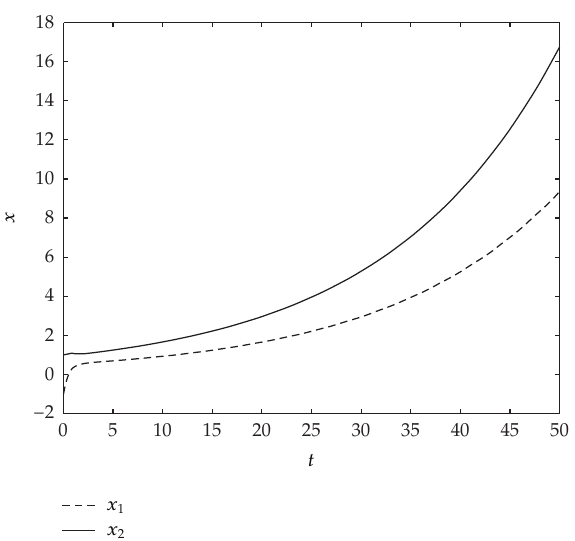
Figure 5: The trajectory of solution of system i (cid:8) 1.